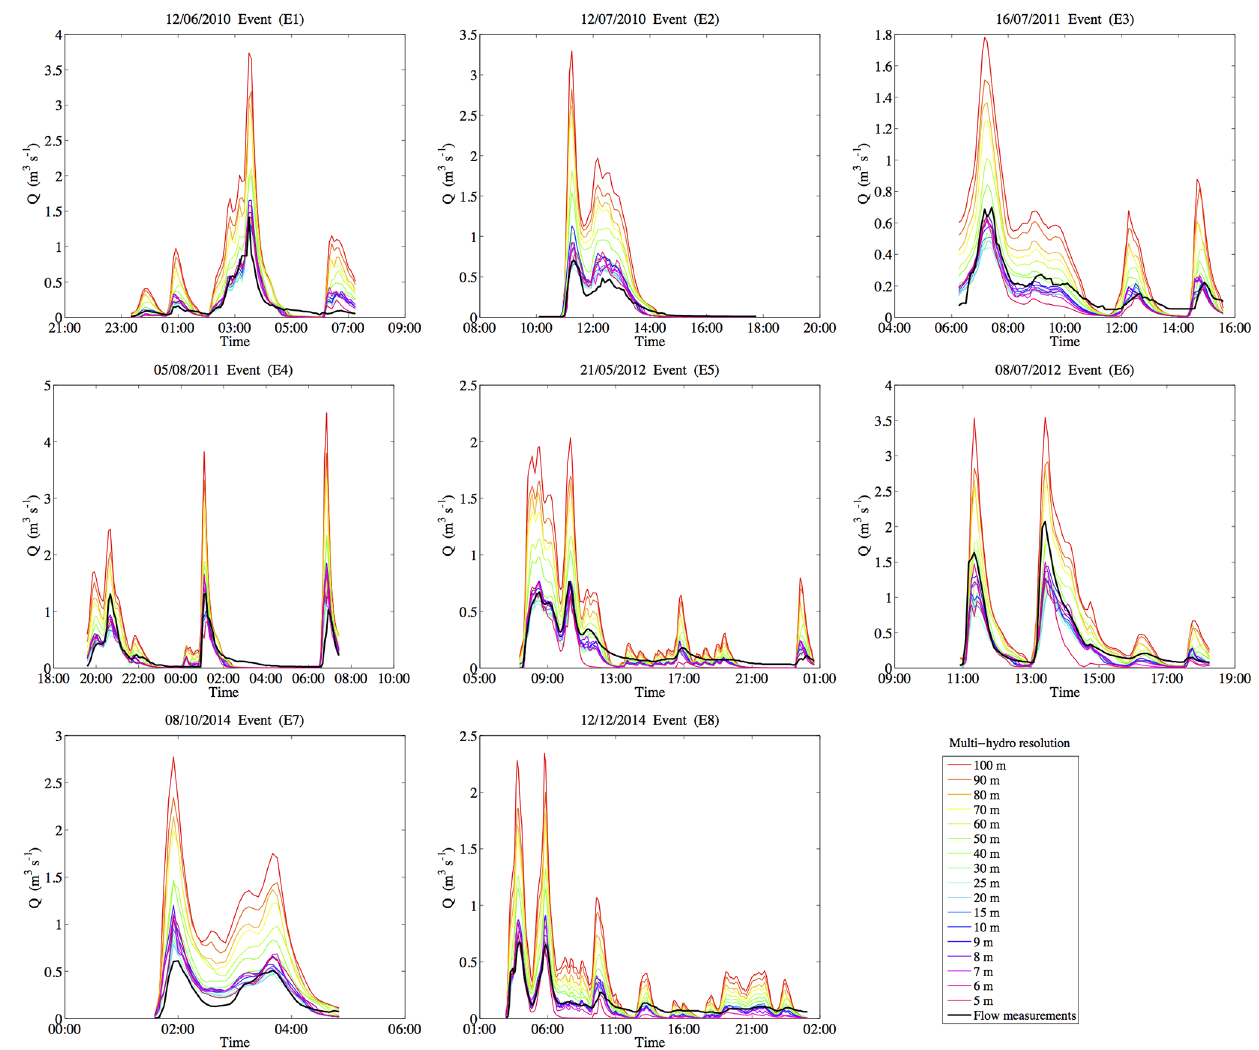
Figure 14. Multi-scale modelling outputs compared with observed flow, showing the high sensitivity of Multi-Hydro response to the spatial resolution of the model.